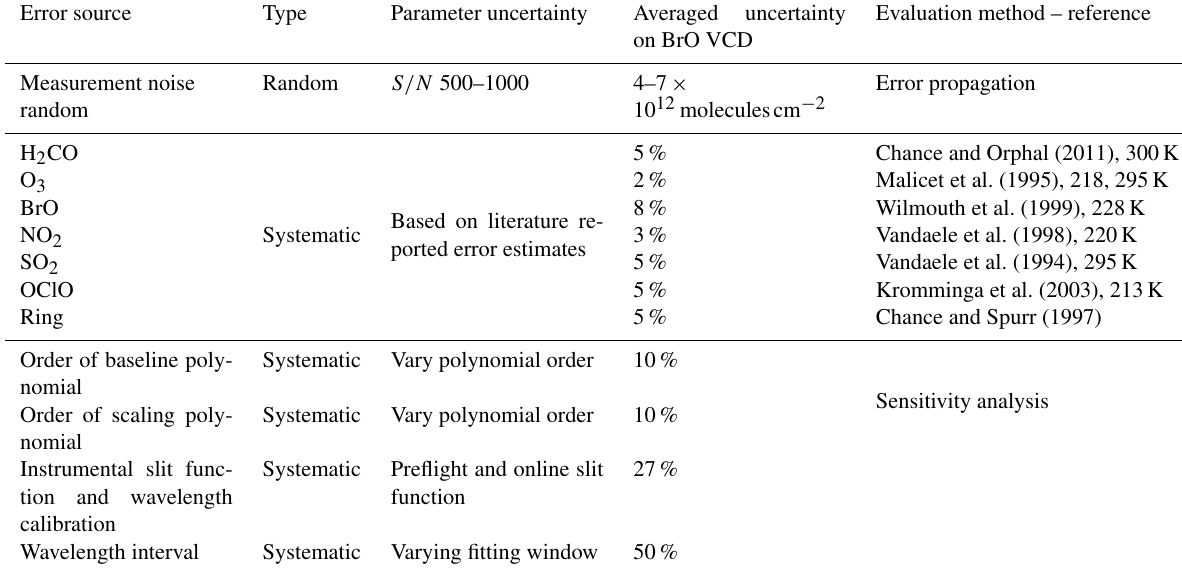
Table 3. Summary of different errors sources in the BrO vertical